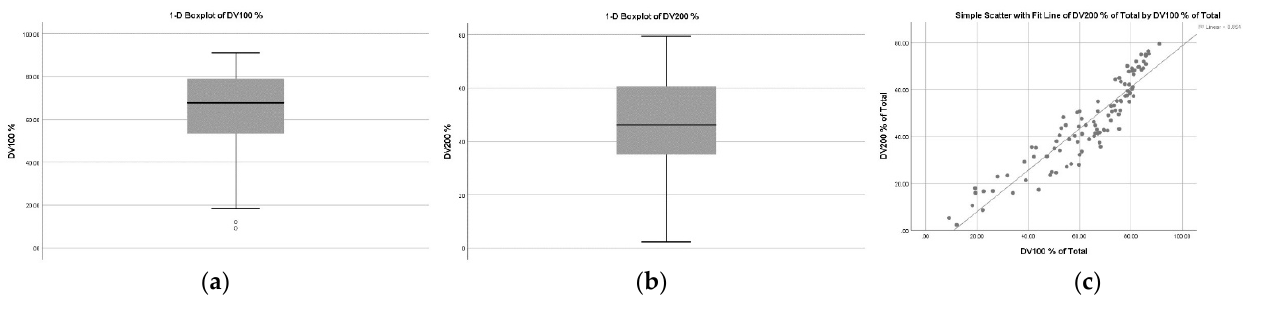
Figure 5. Graphical representation of overall distribution value (dv) in FFPE RNA samples. ( a ): DV100 (Overall) ( b ): DV 200 (Overall) ( c ): Correlation between DV100 and DV200 ( Left to Right ). ( a , b ) describe the box plot of DV 100 and DV200 for RNA samples in the study. ( c ): The correlation between DV100 and DV200 for RNA samples in the study. ◦ represents the ouliers data